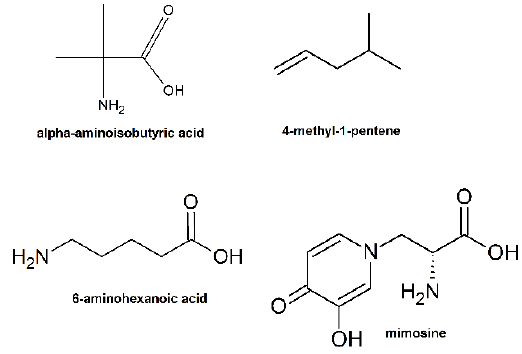
Figure 23. Examples of unnatural amino acids used for the synthesis of AMPs.